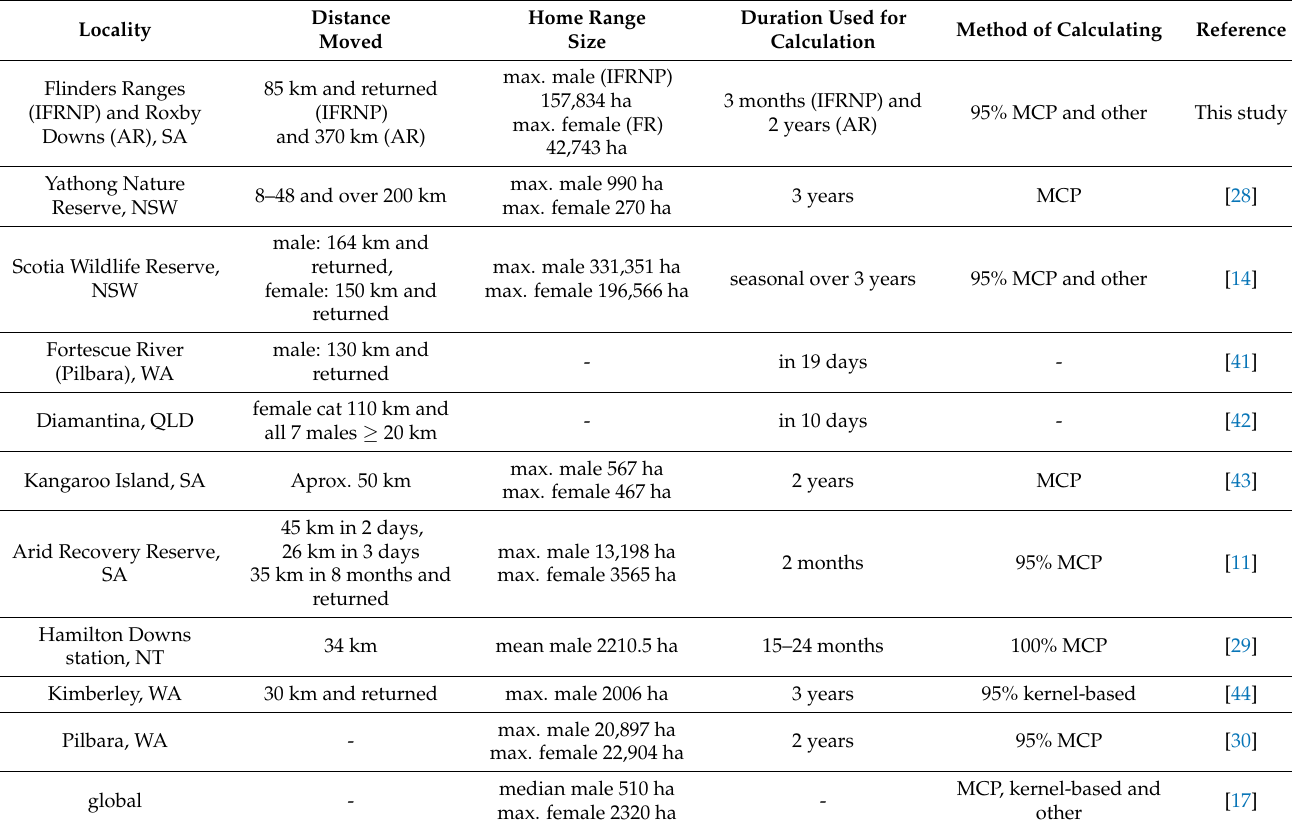
Table 2. Spatial movement and home range of feral cats from other studies in Australia.